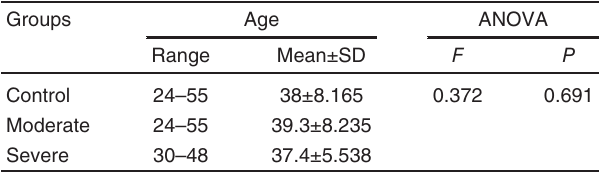
Table 1 Statistical comparison of mean±SD values and of age in the studied groups Groups